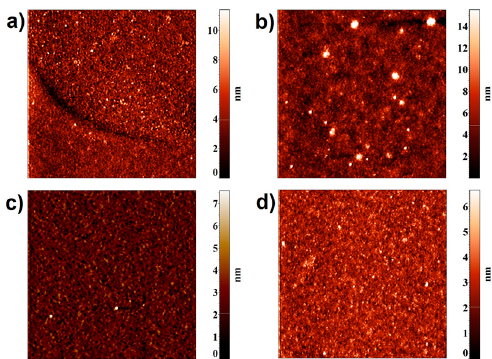
Figure 1. Representative atomic force microscopy (AFM) images of the chip surface after incubation with the serum sample of a healthy volunteer ( a , c ) and an hepatitis C virus (HCV) patient ( b , d ). Images were obtained in working ( a , b ) and in control ( c , d ) sensor areas of the chip. Scan size in each image is 5 × 5 µm 2 ; Z scales are from 0 to 10 nm ( a ); from 0 to 14 nm ( b ); from 0 to 7 nm ( c ); from 0 to 6 nm ( d ).